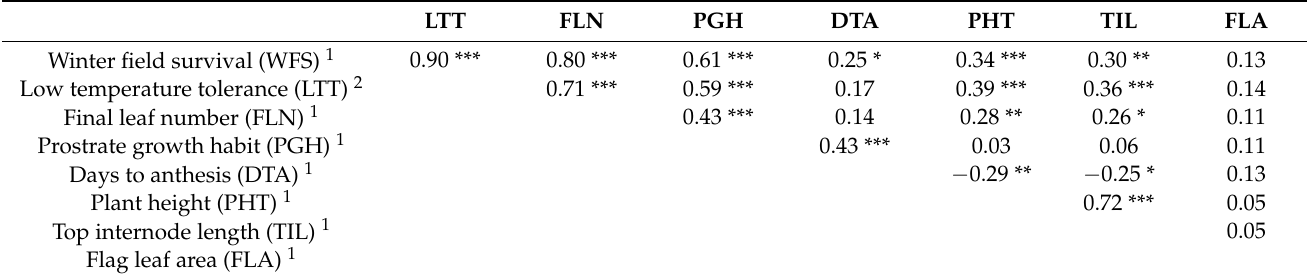
Table 3. Correlations between WFS, LTT, and developmental traits.